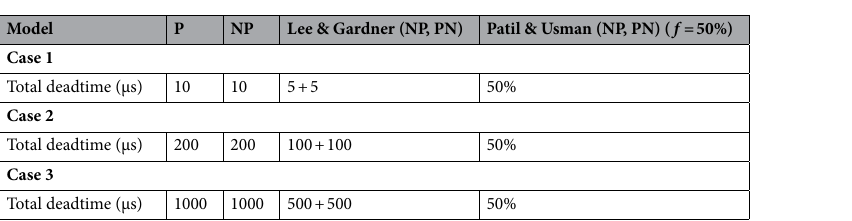
Table 1. Total deadtimes used for simulations for each of the 3 cases. P stands for the Paralyzing model and NP for the non-paralyzing model. In Lee & Gardner’s model, NP stands for the non-paralyzing model followed by paralyzing, whereas PN is the